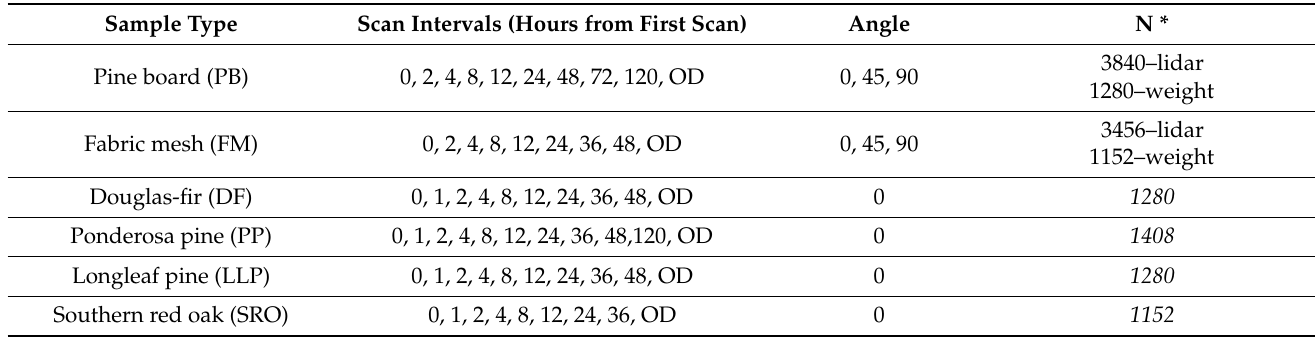
Table 2. Scanning intervals, starting with the time samples were removed from water bath (0). OD refers to oven-dry. N is the total number of sample trays clipped from all lidar point clouds and the number of weights recorded. Only the controls were scanned at angles other than